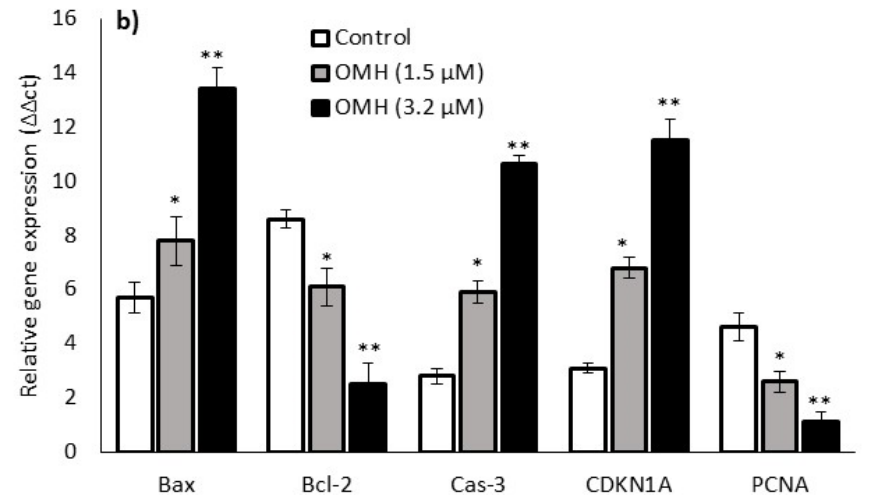
Figure 4. Effect of OMH on antioxidant, tumor suppressor ( a ), and apoptosis-related ( b ) gene expression levels of OMH-treated HT-115 cells after 48 h. Data presented as the means ± SD ( n = 6). Values sharing a common superscript as * p ≤ 0.01 and ** p ≤ 0.05 compared with untreated HT-115 cells.